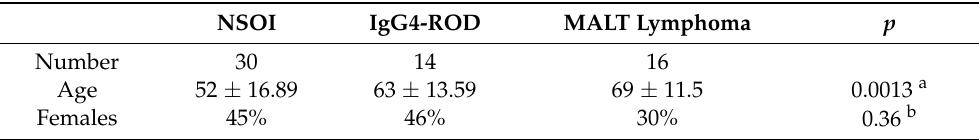
Table 1. Demographic features of patients with non-specific orbital inflammation, IgG4-related orbital disease and orbital MALT lymphoma in our RNA expression analysis